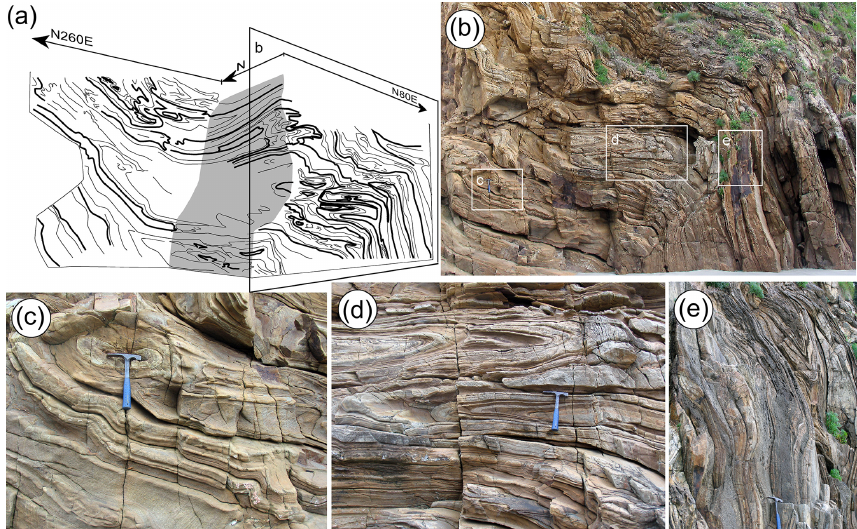
Figure 15. Small-scale parasitic folds related to the recumbent synform folding prior to D 2 -isoclinal folds. Locations of outcrops are indi- cated in Figs. 3 and 14. (a) Sketch of the outcrop section. (b) W–E view of a monocline, with location of the photographs (c) , (d) , and (e) . (c) The apical-section of a D 2 -sheath-fold, behind the hammer, indicates a N–S stretching line. (d) D 2 -intrafolial folds folded by a “Z” parasitic D 3 -fold (reverse limb of the D 3 -recumbent fold). (e) “Z” parasitic D 3 -fold rotated by the D 4 b